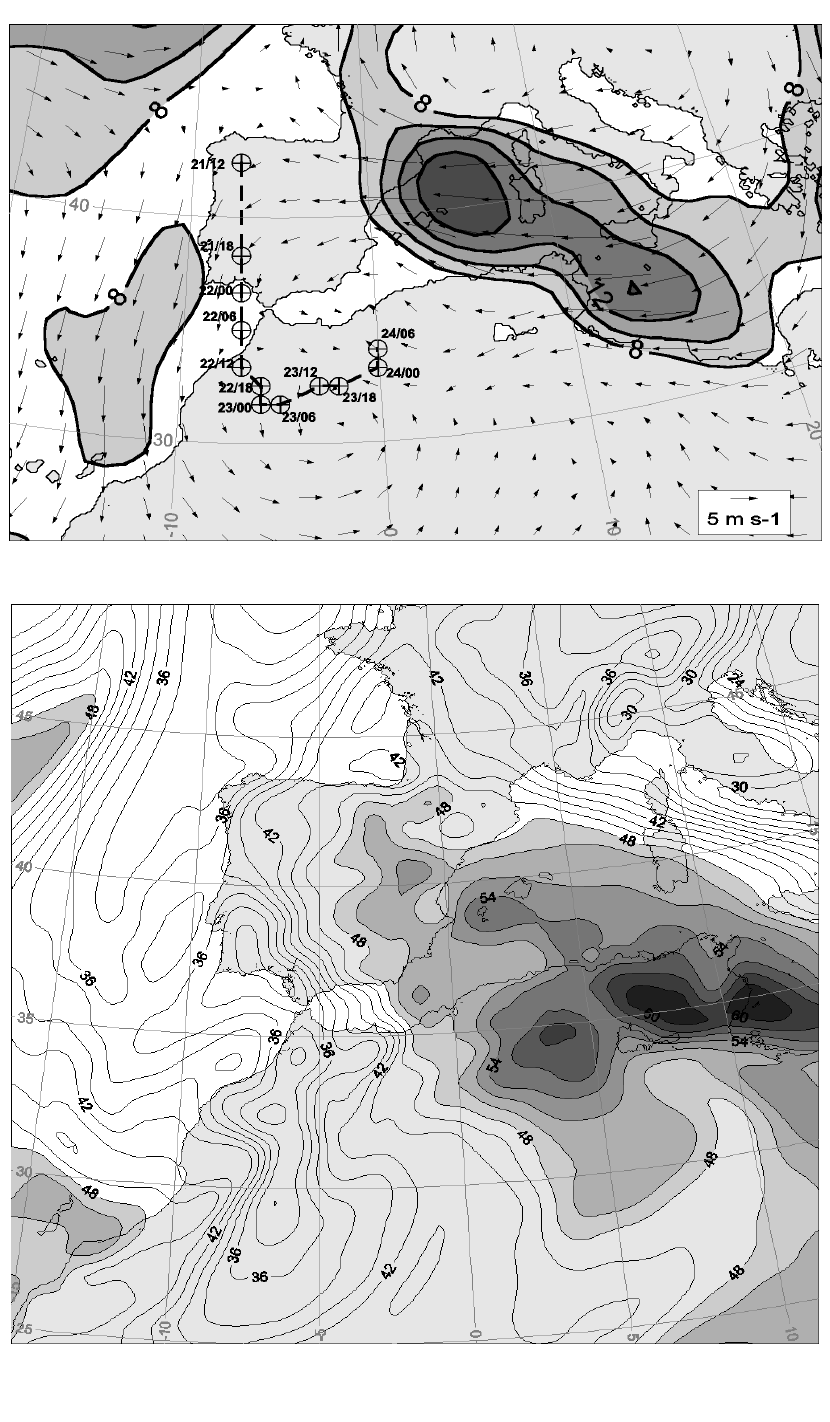
Fig. 9. Distribution on domain 2 of equivalent potential temperature ( ◦ C) at 1000hPa on 12:00UTC 22 Oc- tober 2000, with shading for values greater than 48 ◦